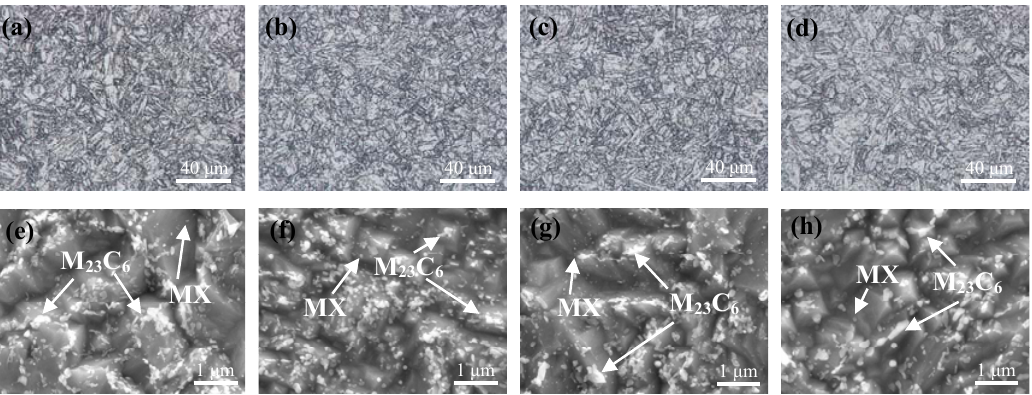
Figure 7. Microstructures ( a–d ) and precipitates ( e–h ) of the tempered RAFM steels: ( a , e ) C1; ( b , f ) C2; ( c , g ) C3; and ( d , h ) C4.